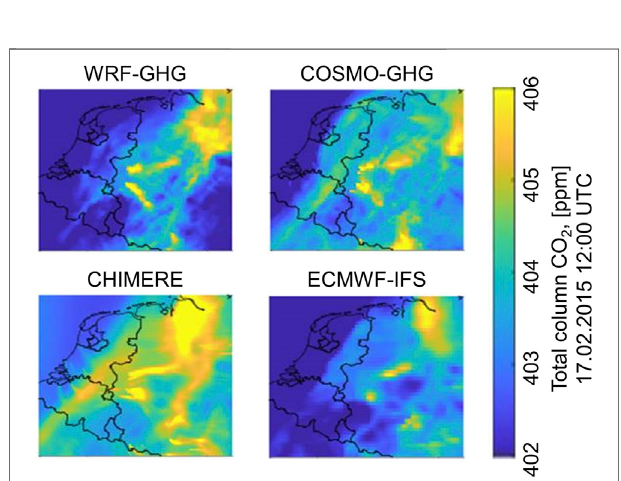
FIGURE 3 | Examples ofCHE European regional CO 2 mole fractions valid for the February 17, 2015, centred over Berlin (Germany) with a focus on stacks fromindustryandpowerplantsobtainedbysimulationwithWRF-GHG,COSMO- GHG and CHIMERE (see Table 1 ), and comparison with the ECMWF-IFS.